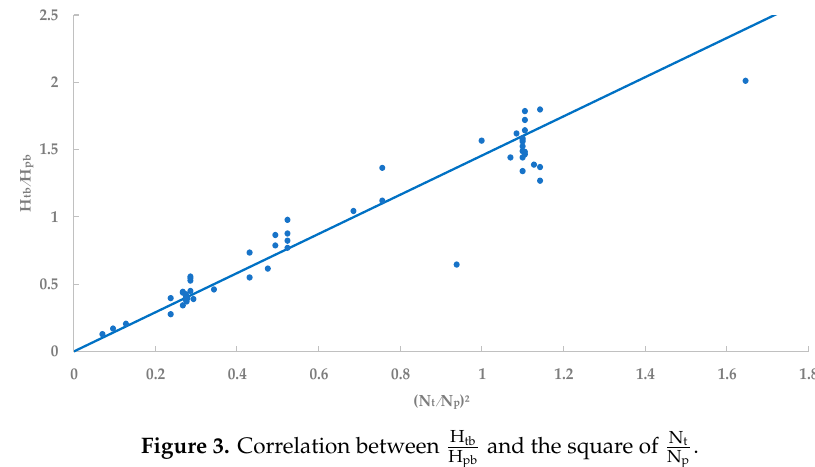
Figure 3. Correlation between H tb